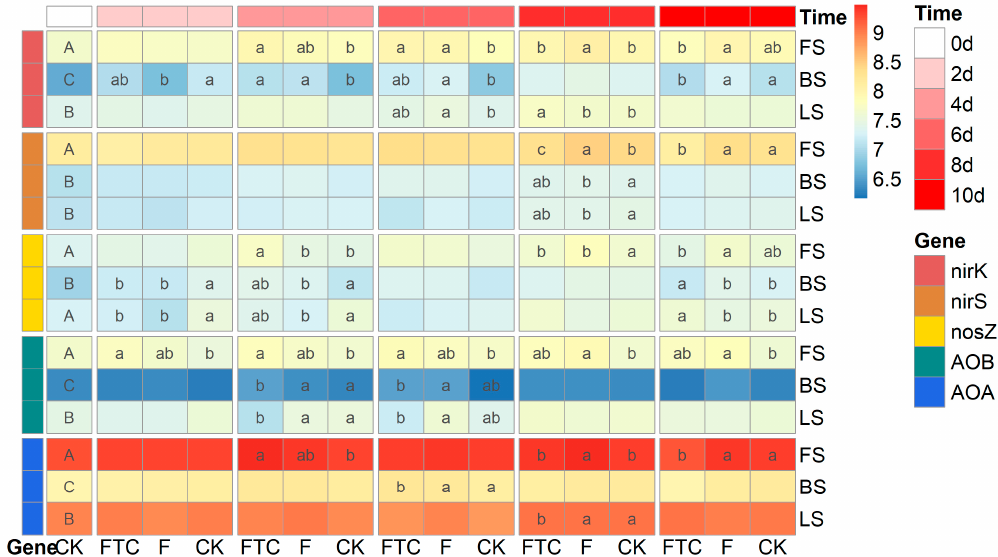
TC, total carbon; TN, total nitrogen; C/N, TC/TN; DOC, dissolved organic carbon; SOC, soil organic carbon; DON, dissolved organic nitrogen; FS, fluvo-aquic soil; BS, black soil; LS, loess soil. Each number represents the average values of three replicates, and the different letters indicate significant differences according to ANOVA with Tukey’s test ( p < 0.05).